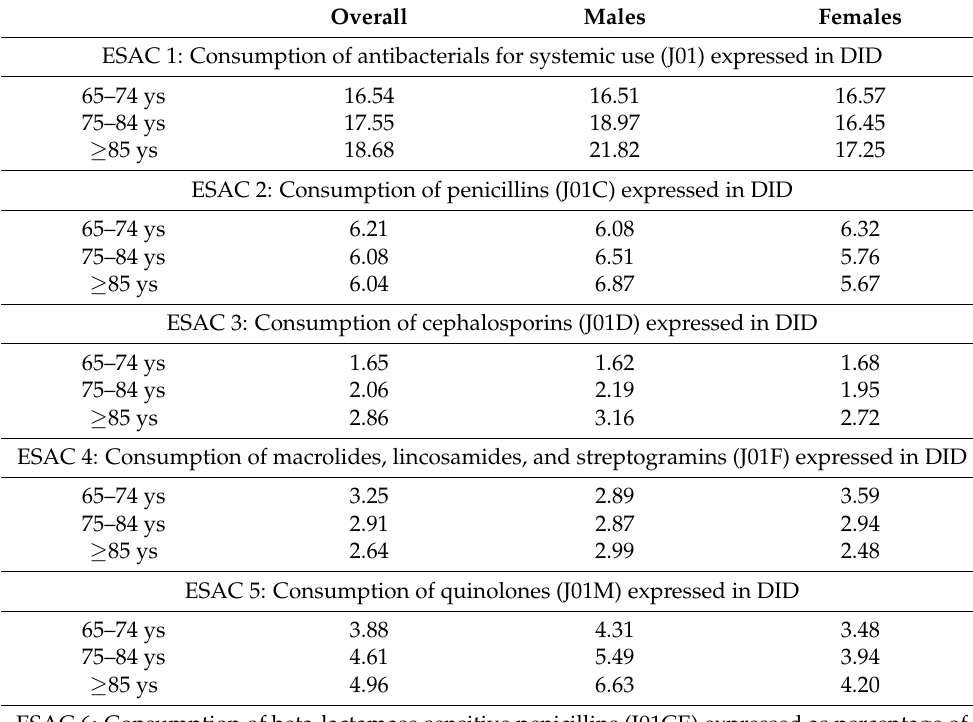
Table 3. Evaluation of the ESAC-based indicators, by sex and age groups. Overall Males